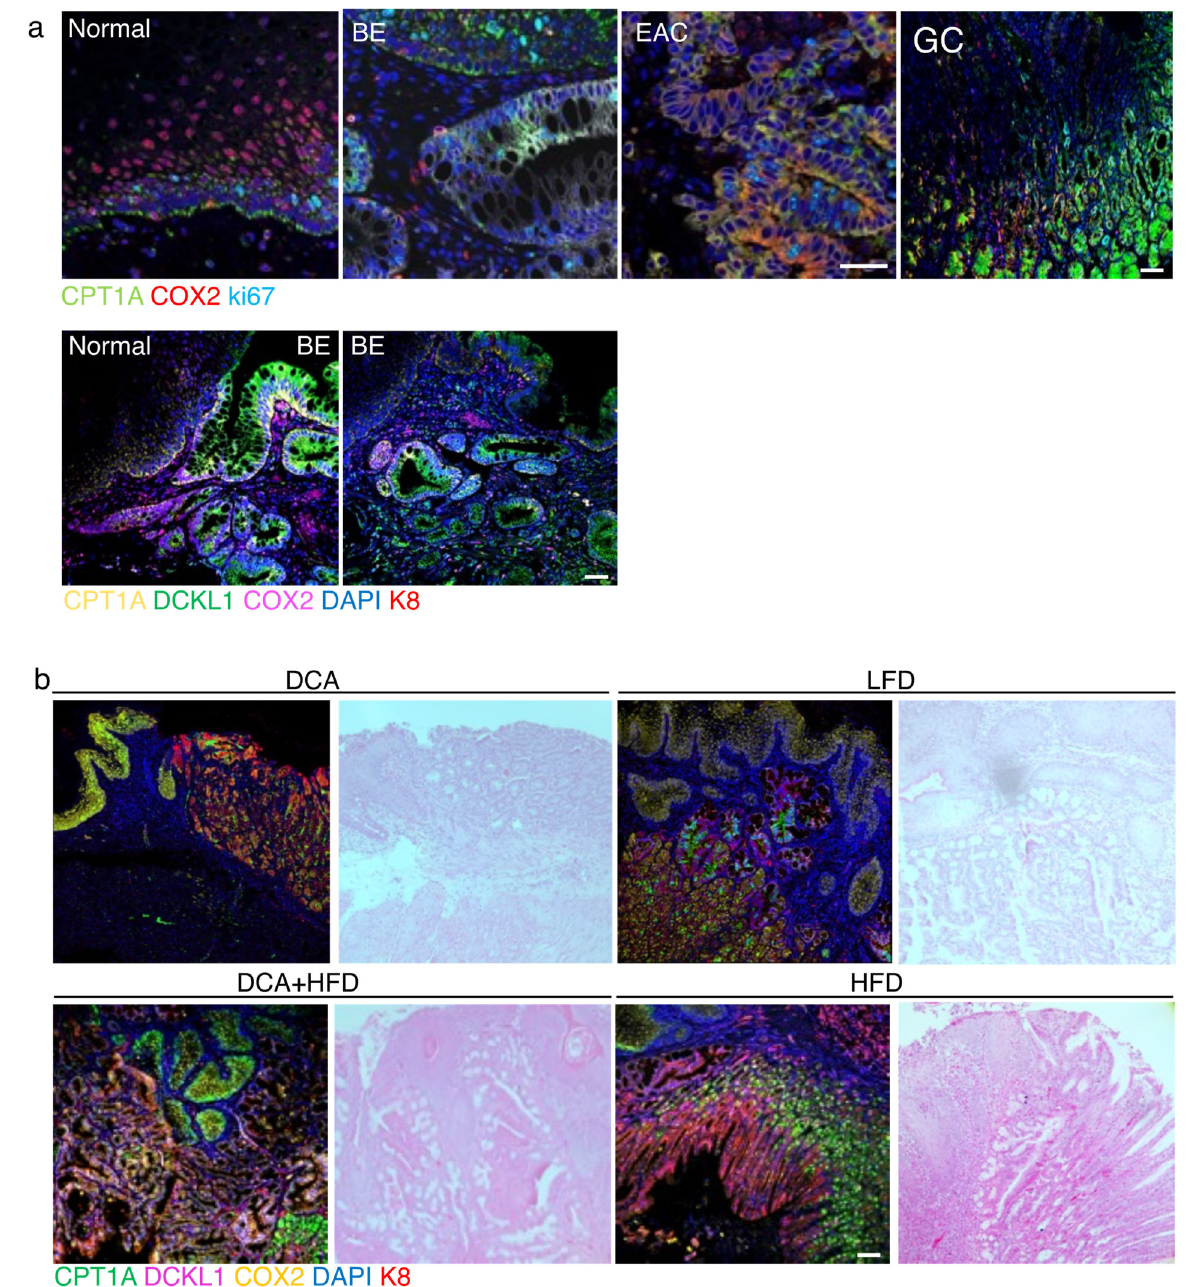
Figure 6. CPT1A upregulation correlates with an increase in COX2 and DCLK1 in human and mouse. ( a ) Human biospecimen from normal, Barrett’s (BE), esophageal adenocarcinoma (EAC) and gastric cardia were stained with antibody against CPT1A, COX2 and ki67. CPT1A and COX2 expression are increased in BE, EAC as is ki67. In biopsies capturing the junction of healthy squamous and BE, the increase in CPT1A and the stemness marker DCLK1 localize to the BE lesion, also identified with K8 using multiplex immunofluorescence staining. ( b ) ED-L2- IL1 β mice were exposed to deoxycholate (DCA) in the drinking water, low fat diet (LFD) or high fat diet (HFD) alone and in combination with DCA. The combination treatment results in a high signal for the detection of CPT1A, DCLK1 and COX2 in K8-positive BE-like regions. Scale bar, 50 microns.